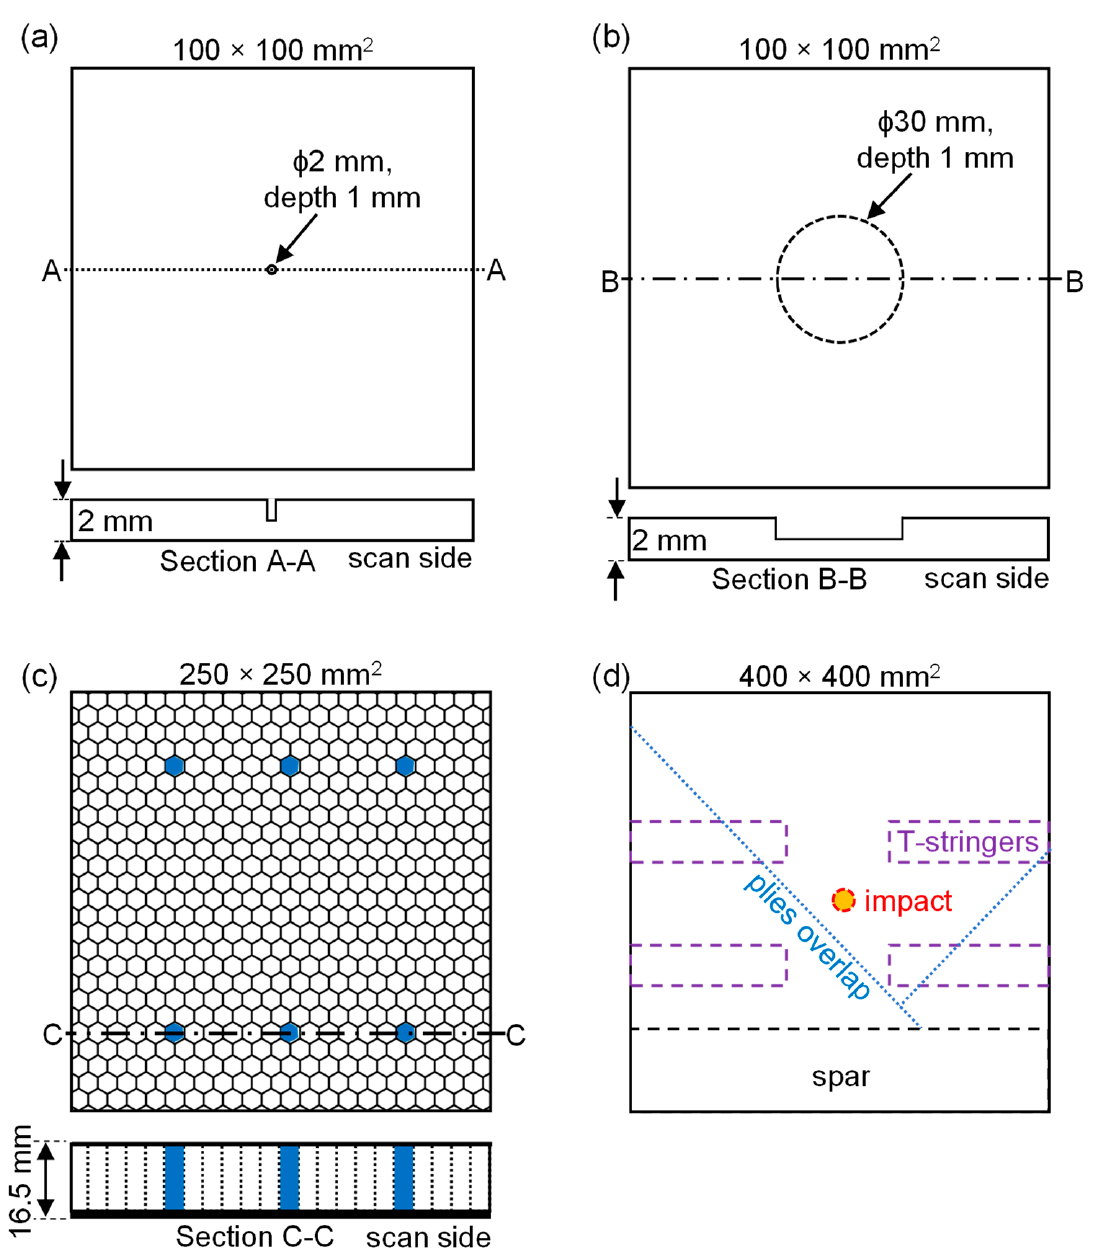
Figure 5. Illustration of an ROI showing the relative position of damage for ( a ) Case D1, ( b ) Case D2, ( c ) Case D3 with six water-filled honeycomb cells, and ( d ) Case D4. In sub-figure ( d ), purple dashed boxes, blue dashed lines, and black dashed line indicate the position of T-stringers, plies overlap, and spar, respectively.